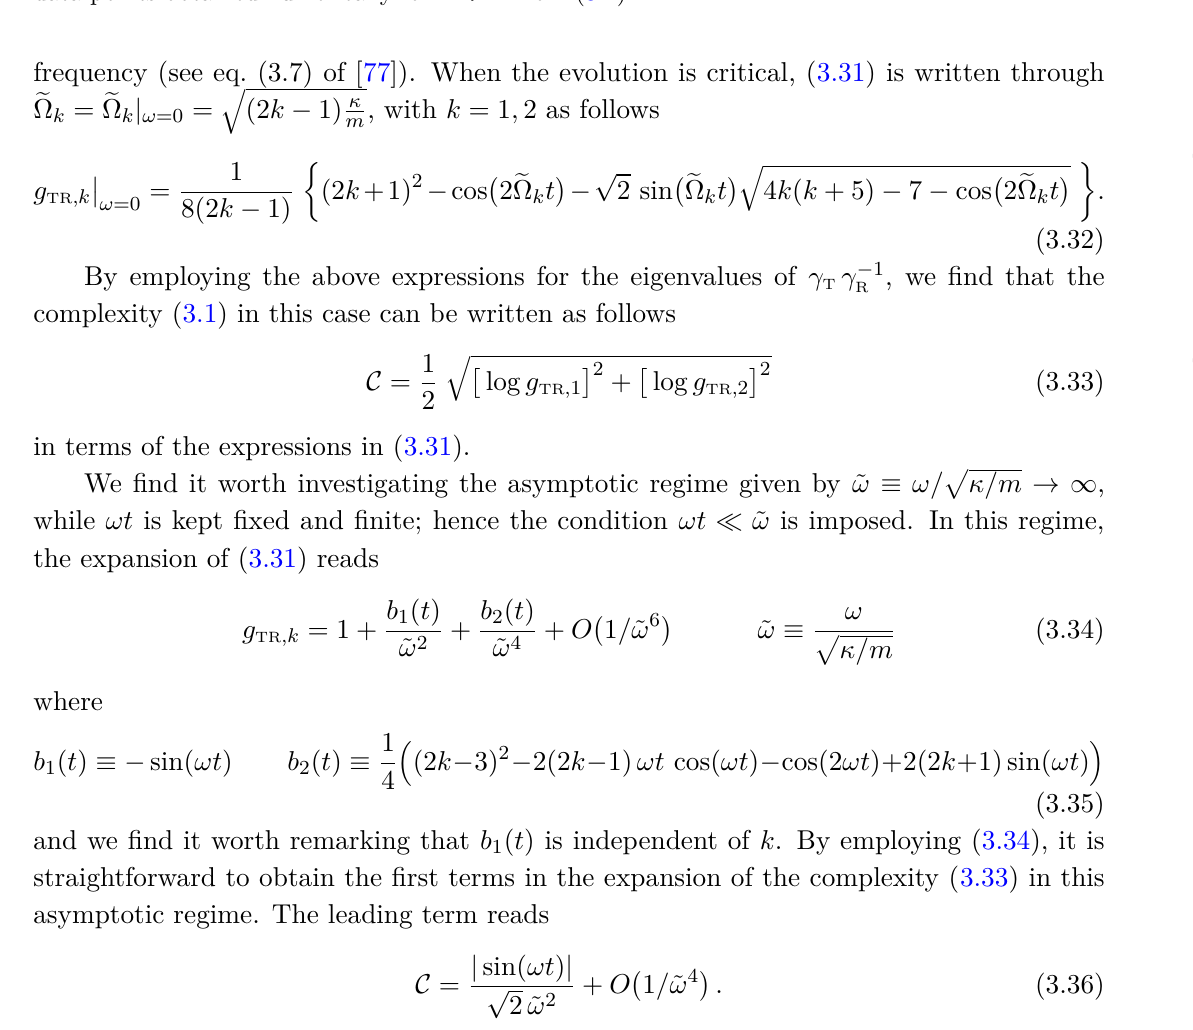
Figure 5 . Temporal evolution of the complexity C for the chain made by two sites after a local quench with various ω w.r.t. the initial state. Setting κ = 1 and m = 1 , in the left panel (3.33) is shown as function of e Ω 1 t (see below (3.31)), while in the right panel (3.36) is compared against data points obtained numerically for N > 2 from